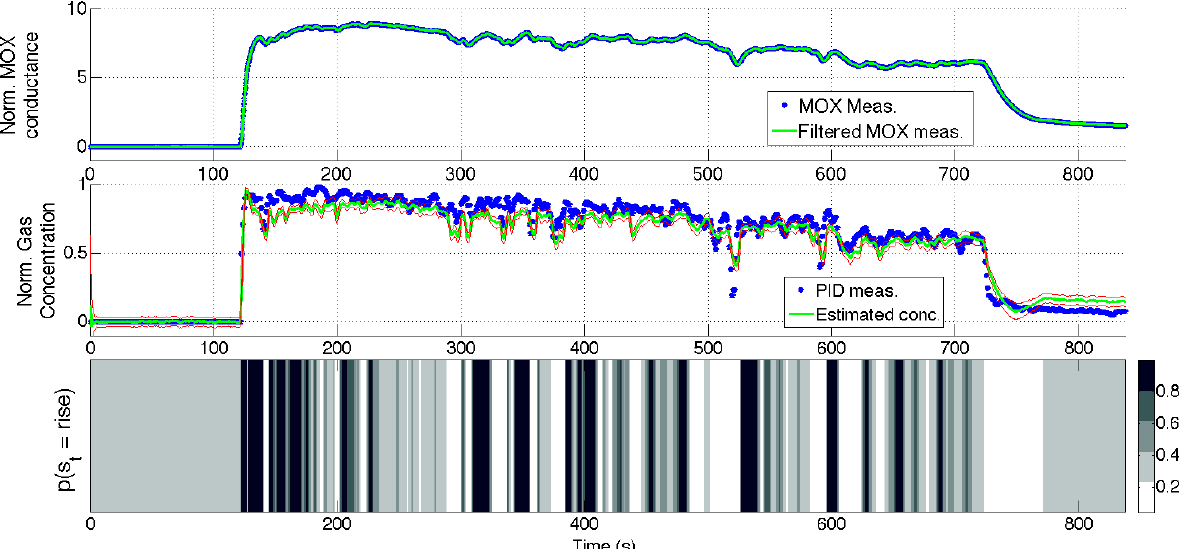
Figure 12. aSLDS inference results for an experiment of dataset Descending Stairway . ( Top ) MOX measurements, ( Middle ) Gas concentration, ( Bottom ) Sensor phase probability